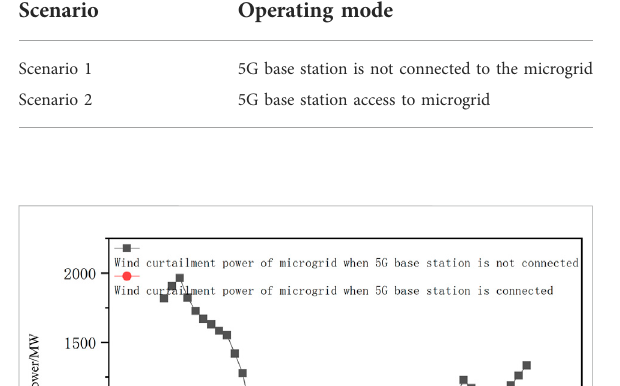
TABLE 3 Operation modes.